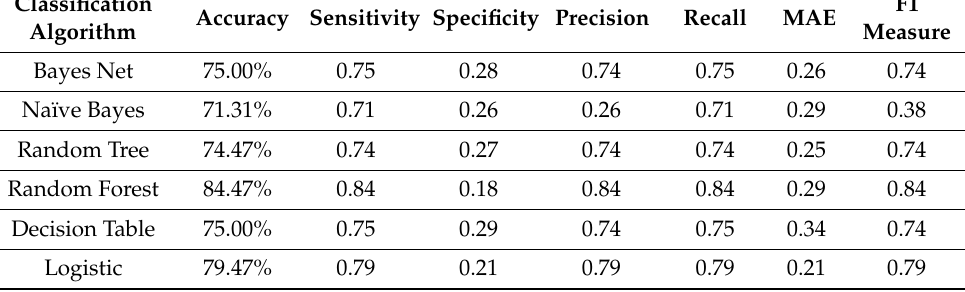
Table 13. Hybrid feature fusion results for Dataset-II.